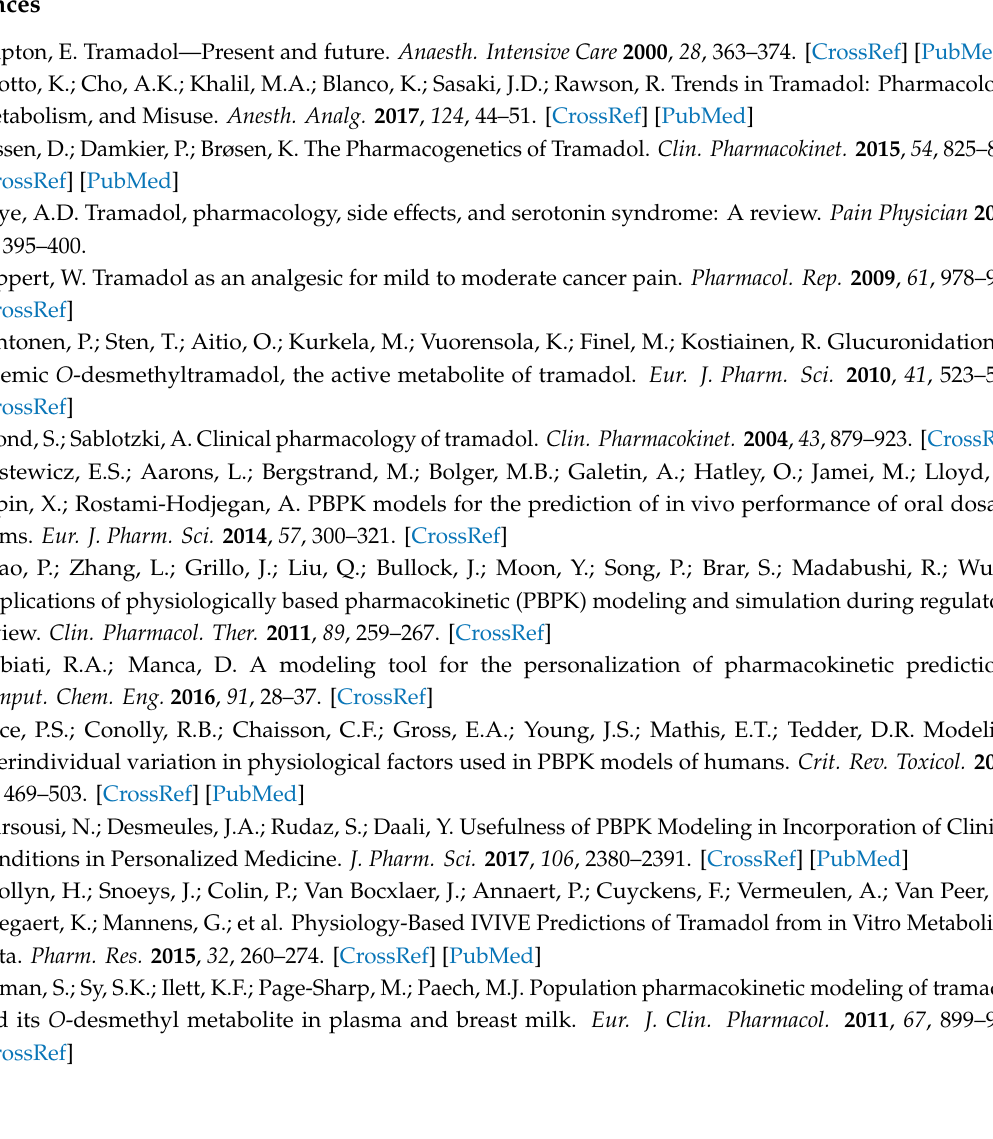
Figure S1: The predicted mean tramadol and O -desmethyltramadol concentration-time profiles after administration of 100 mg tramadol ER tablet twice daily (five times in total) for CYP2D6 poor metabolizer, intermediate metabolizer, extensive metabolizer and ultra-rapid metabolizer, respectively; Figure S2: The predicted mean tramadol and O -desmethyltramadol concentration-time profiles after administration of 200 mg tramadol ER tablet twice daily (five times in total) for CYP2D6 poor metabolizer, intermediate metabolizer, extensive metabolizer and ultra-rapid metabolizer,